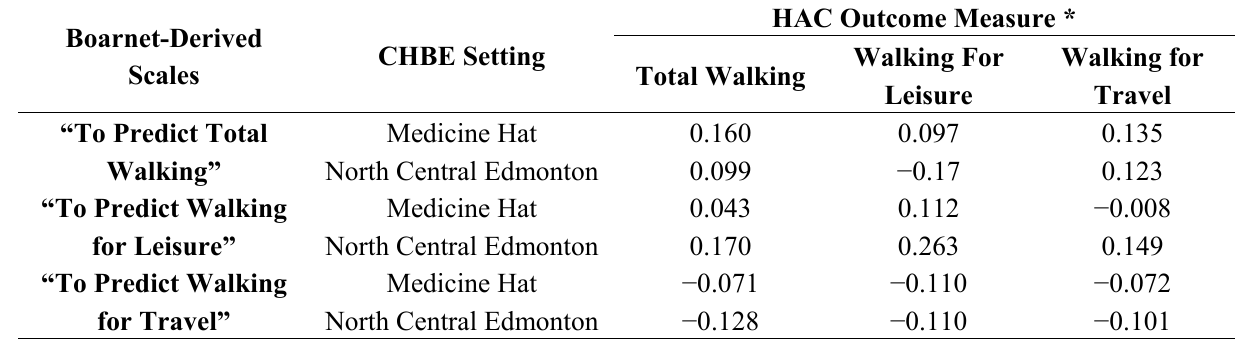
Table 2. Correlations between Boarnet et al . scales and HAC outcome